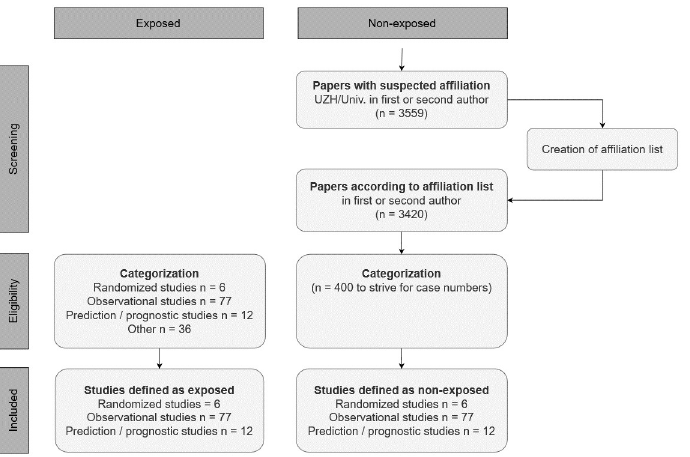
Fig 1. Flow chart. Selection process for the exposed publications (left) and the non-exposed publications (right), including screening of affiliation lists of first and second author.